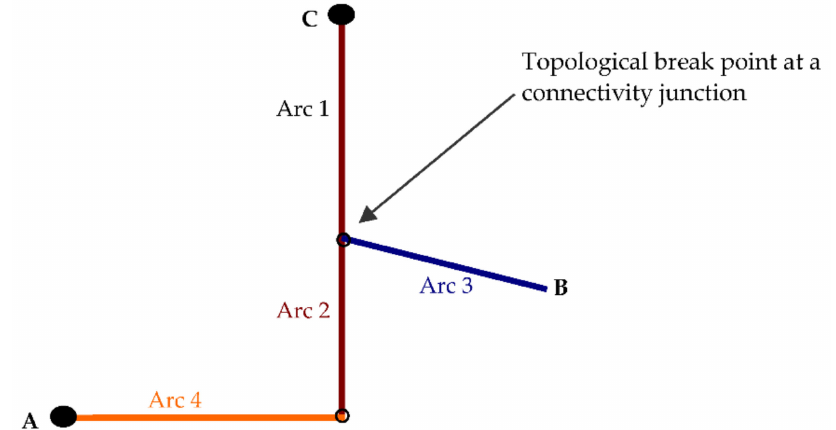
Figure 7. Topological break-point